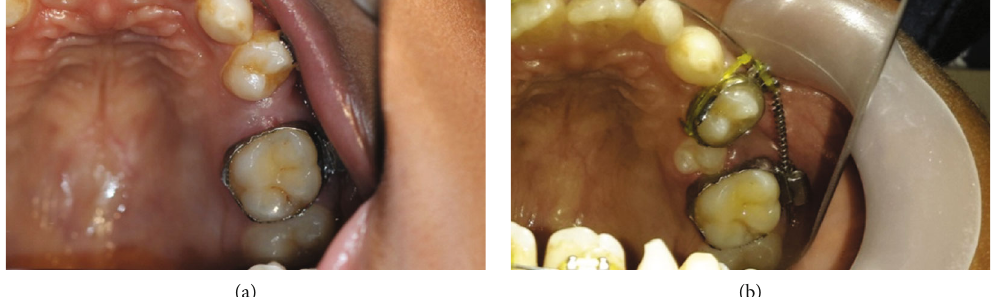
Figure 9: Intraoral photographs of 25 (a) before and (b) after surgical exposure.